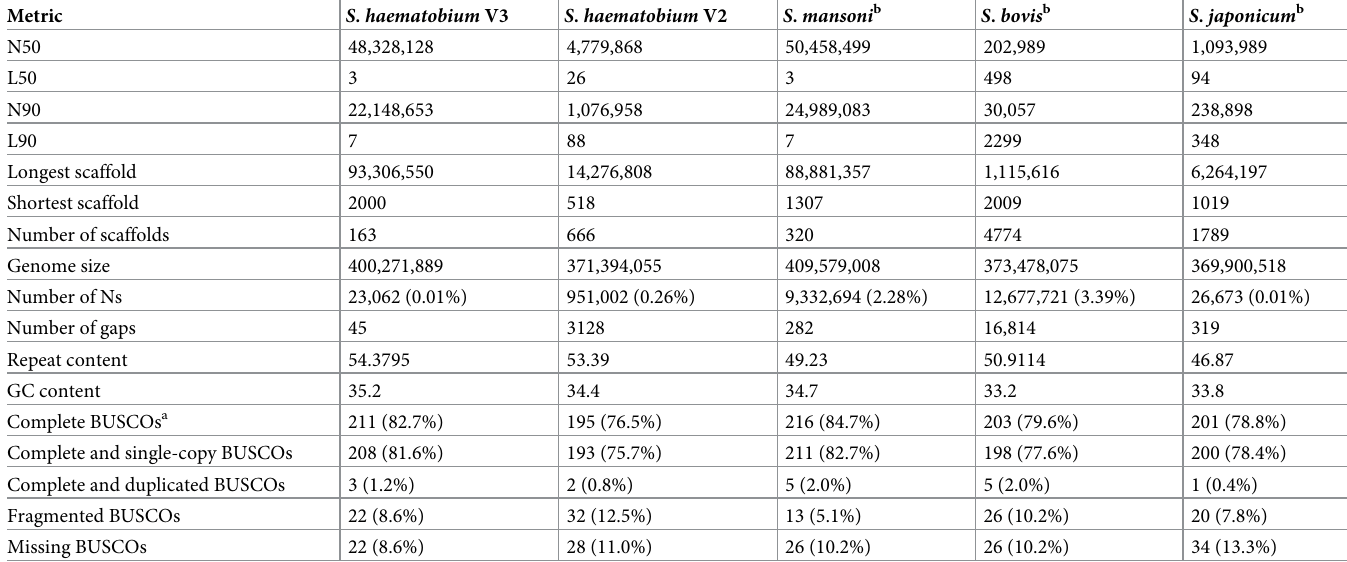
Table 1. Key metrics of the Schistosoma haematobium Shae.V3 assembly and comparison with assemblies for other key schistosome species. Metric